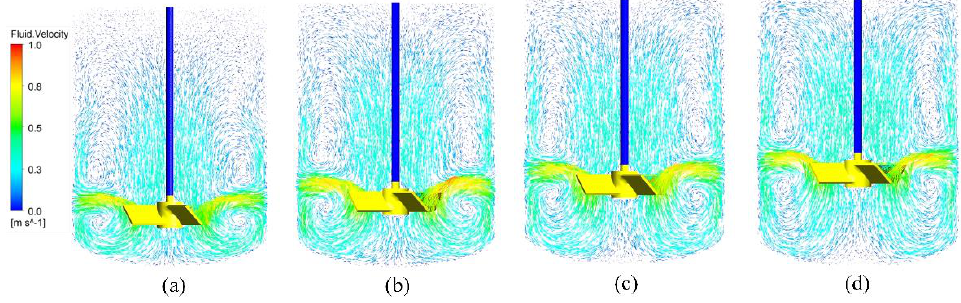
Figure 12. The velocity profile of fluid in the four stirred tanks with different blade heights. h = ( a ) 30 mm, ( b ) 40 mm, ( c ) 50 mm, ( d ) 60 mm, respectively, t = 5 s.